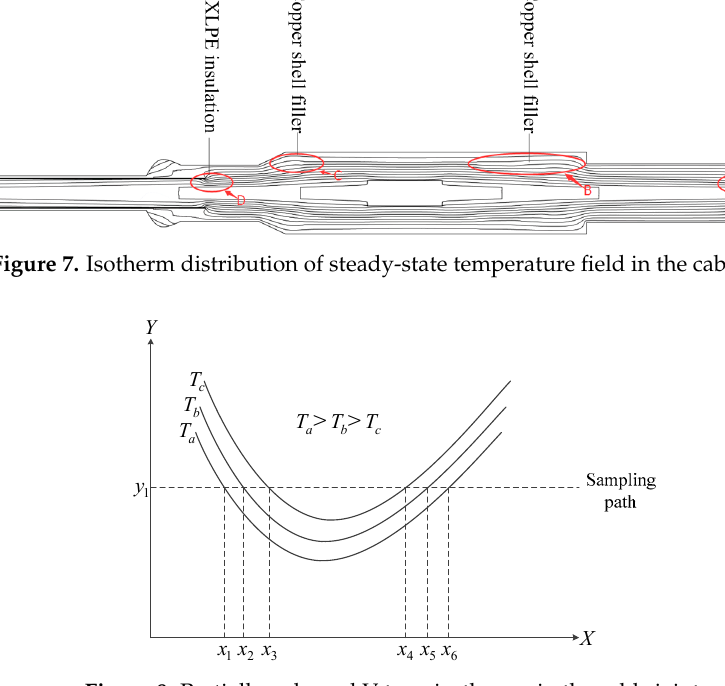
Figure 8. Partially enlarged V-type isotherms in the cable joint.